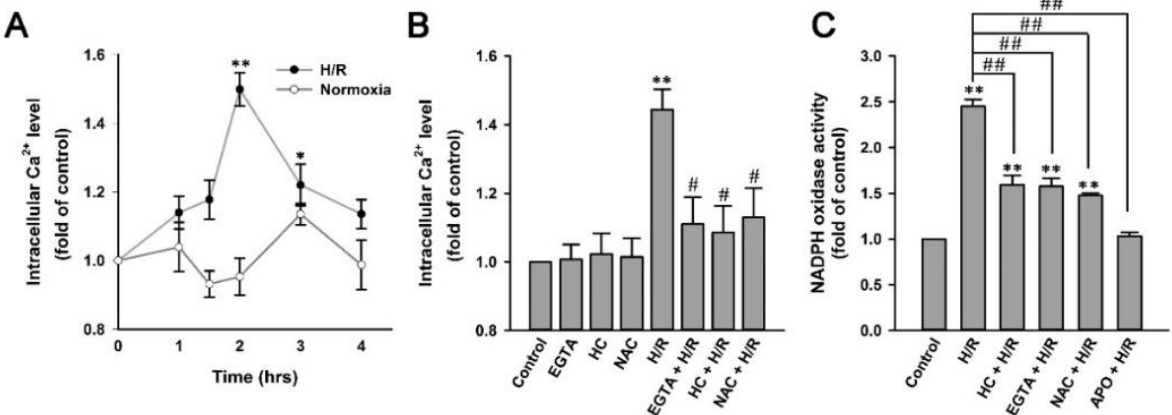
Figure 7. H/R causes ROS-dependent, TRPA1-mediated increases in intracellular Ca 2+ and NADPH oxidase activity in HK-2 cells. ( A ) HK-2 cells were incubated under normoxia conditions or exposed to 2.5% O 2 for 6 h, followed by 1, 1.5, 2, 3, and 4 h of reoxygenation. ( B ) HK-2 cells were incubated under normoxia conditions as control or exposed to 2.5% O 2 for 6 h, followed by 2 h of reoxygenation. In 6 study groups, cells were pretreated with EGTA (an extracellular Ca 2+ chelator; 500 µ M), HC-030031 (HC, a TRPA1 antagonist; 9 µ M) or N-acetyl-cysteine (NAC, a scavenger of ROS; 1 mM). ( C ) HK-2 cells were incubated under normoxia conditions as control or exposed to 2.5% O 2 for 6 h, followed by 2 h of reoxygenation. In 4 study groups, cells were pretreated with HC-030031, EGTA, NAC or apocynin (APO; an inhibitor of NADPH oxidase; 150 µ M). Intracellular Ca 2+ levels were measured by Fluo-8 fluorescent probe assay. NADPH oxidase activity was measured by NADP + /NADPH assay. Data in each group are mean ± SEM from 5 independent experiments. ** p < 0.01 versus the control group or time zero; # p < 0.05 versus the H/R group without drug pretreatment; ## p < 0.01 versus the H/R group without drug